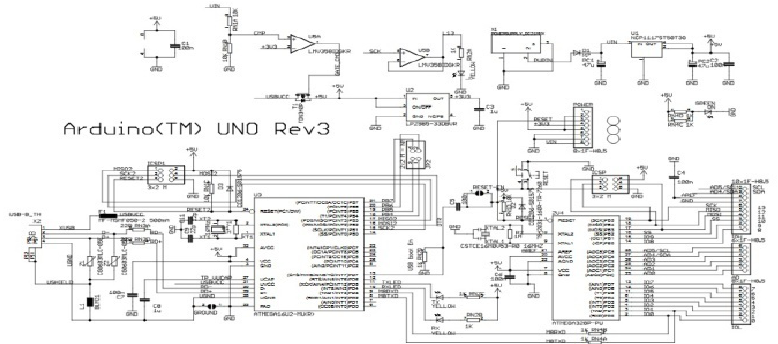
Fig. 2. The schematic diagram of Arduino Uno board